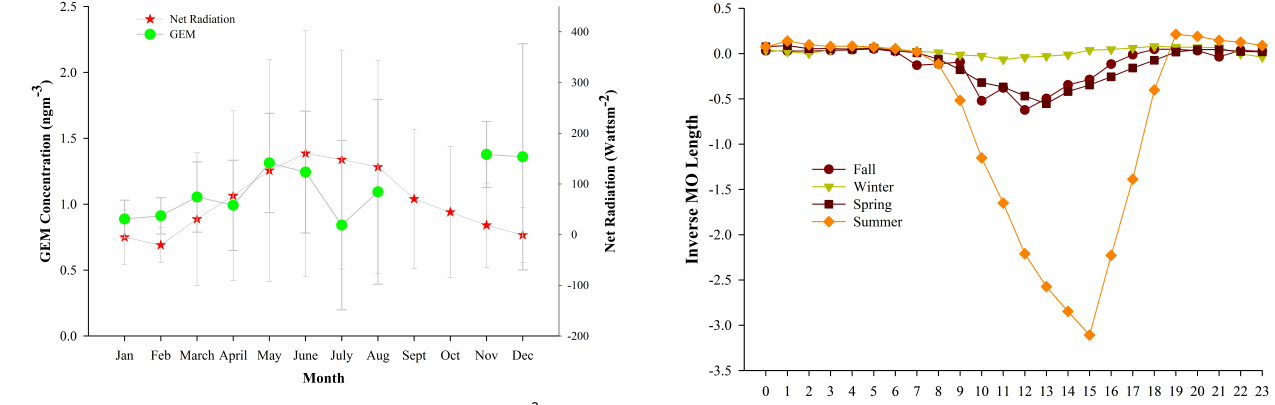
Fig. 3. Average monthly GEM concentrations (ngm − 3 ) and net radiation (wattsm − 2 ) measured during the study at Elora Research Station, ON (1 November 2006 to 29 June 2007). Fig. 4. Seasonal hourly average values for the inverse Monin